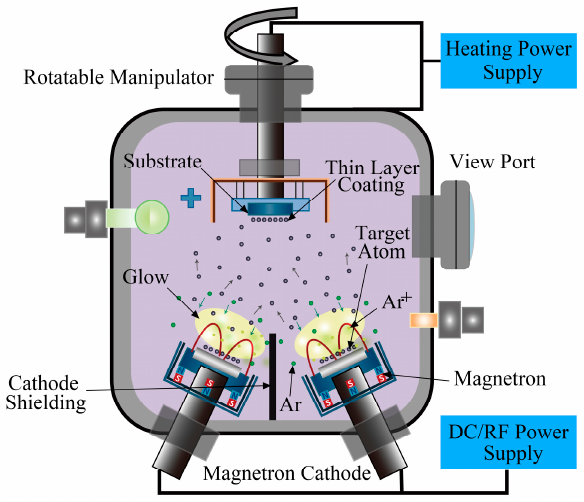
Figure 1. Schematic of the experimental setup. Table 1. Deposition parameters of the Si-B-C-N/DLC gradient films.